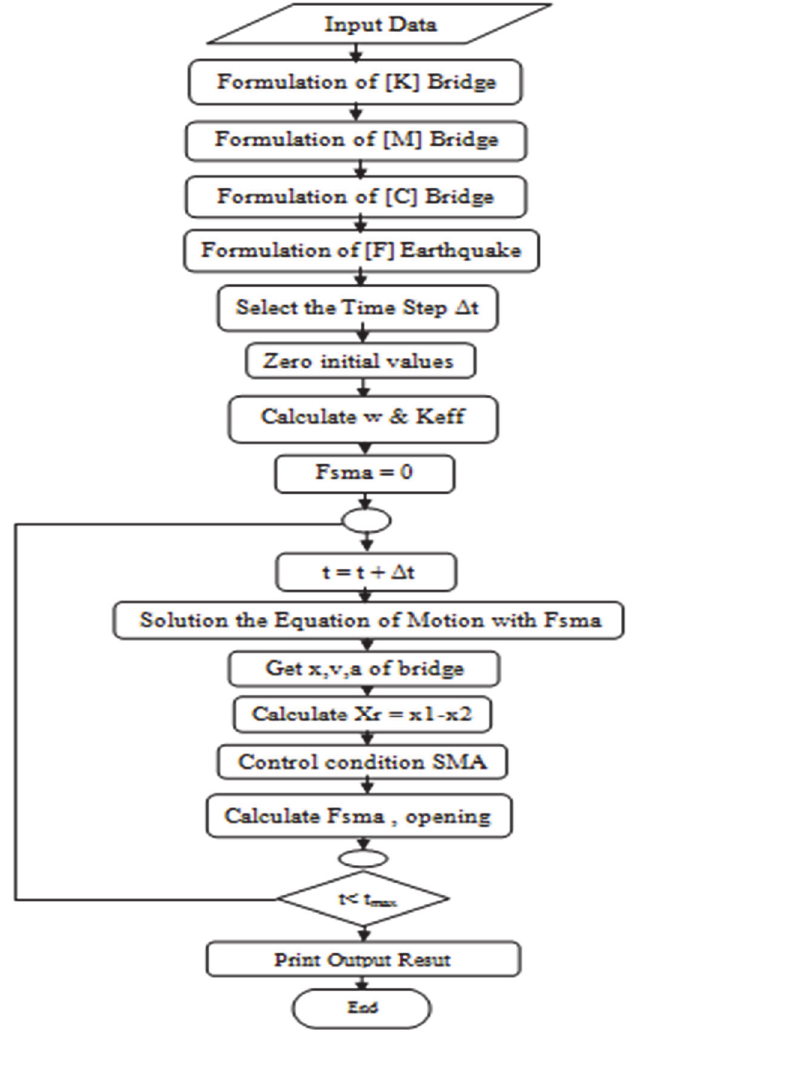
Figure 4: Flow chart of a developed program for a bridge with